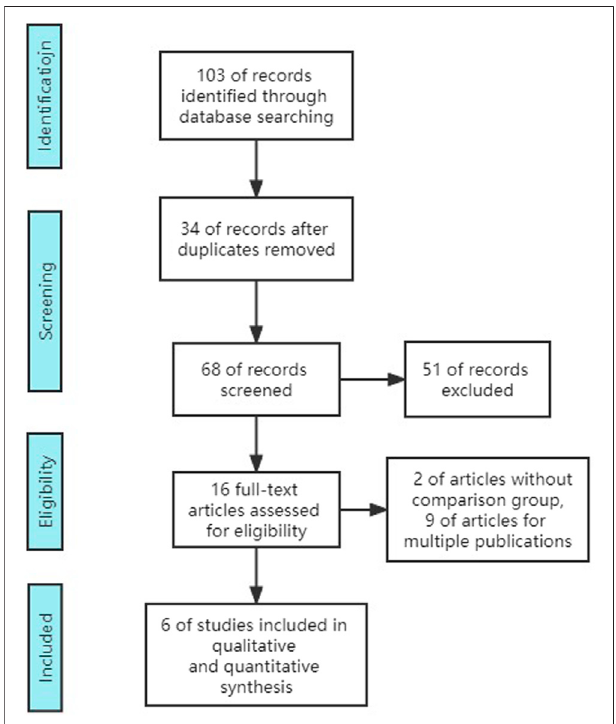
FIGURE 1 | PRISMA fl ow diagram of eligible